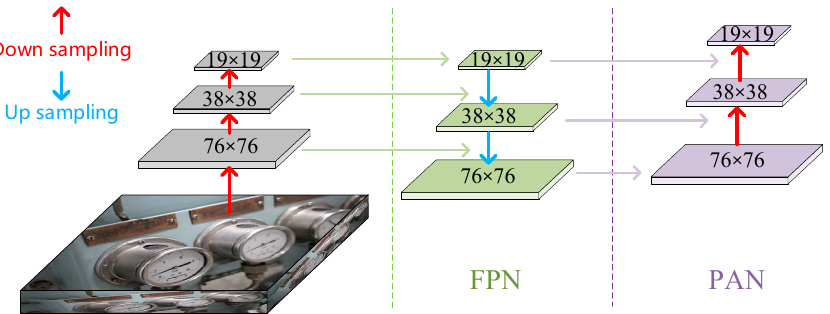
Figure 6. Schematic diagram of FPN + PAN.